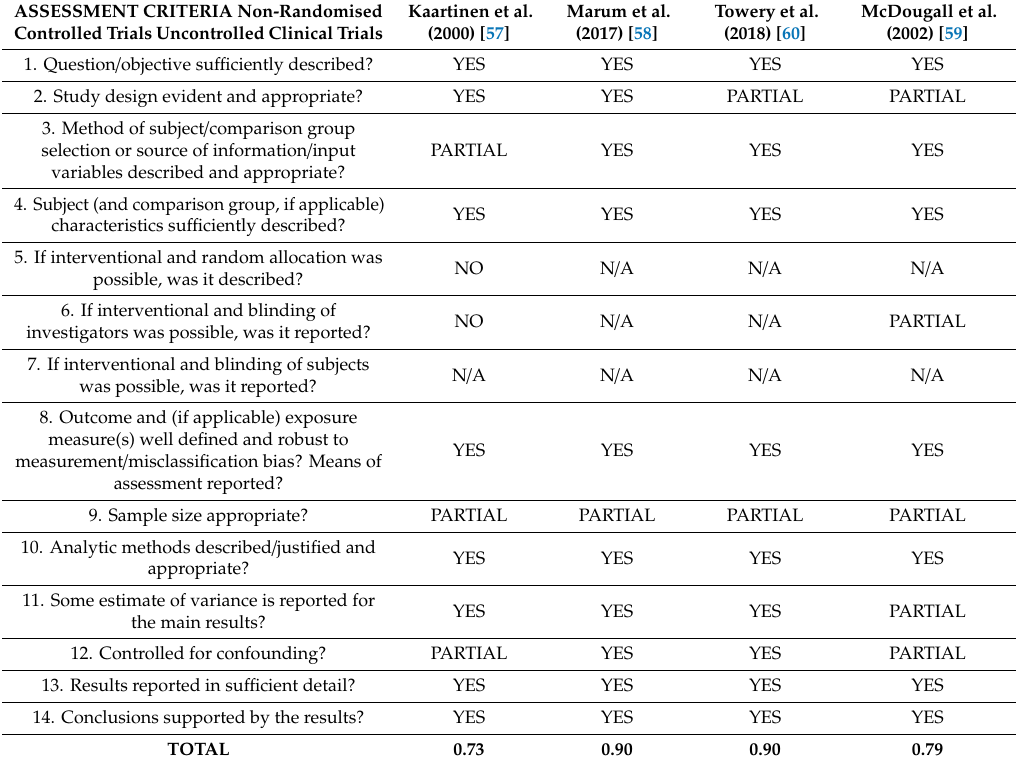
Table 3. Risk of bias assessment of non-randomised controlled and uncontrolled clinical trials. ASSESSMENT CRITERIA Non-Randomised Controlled Trials Uncontrolled Clinical Trials